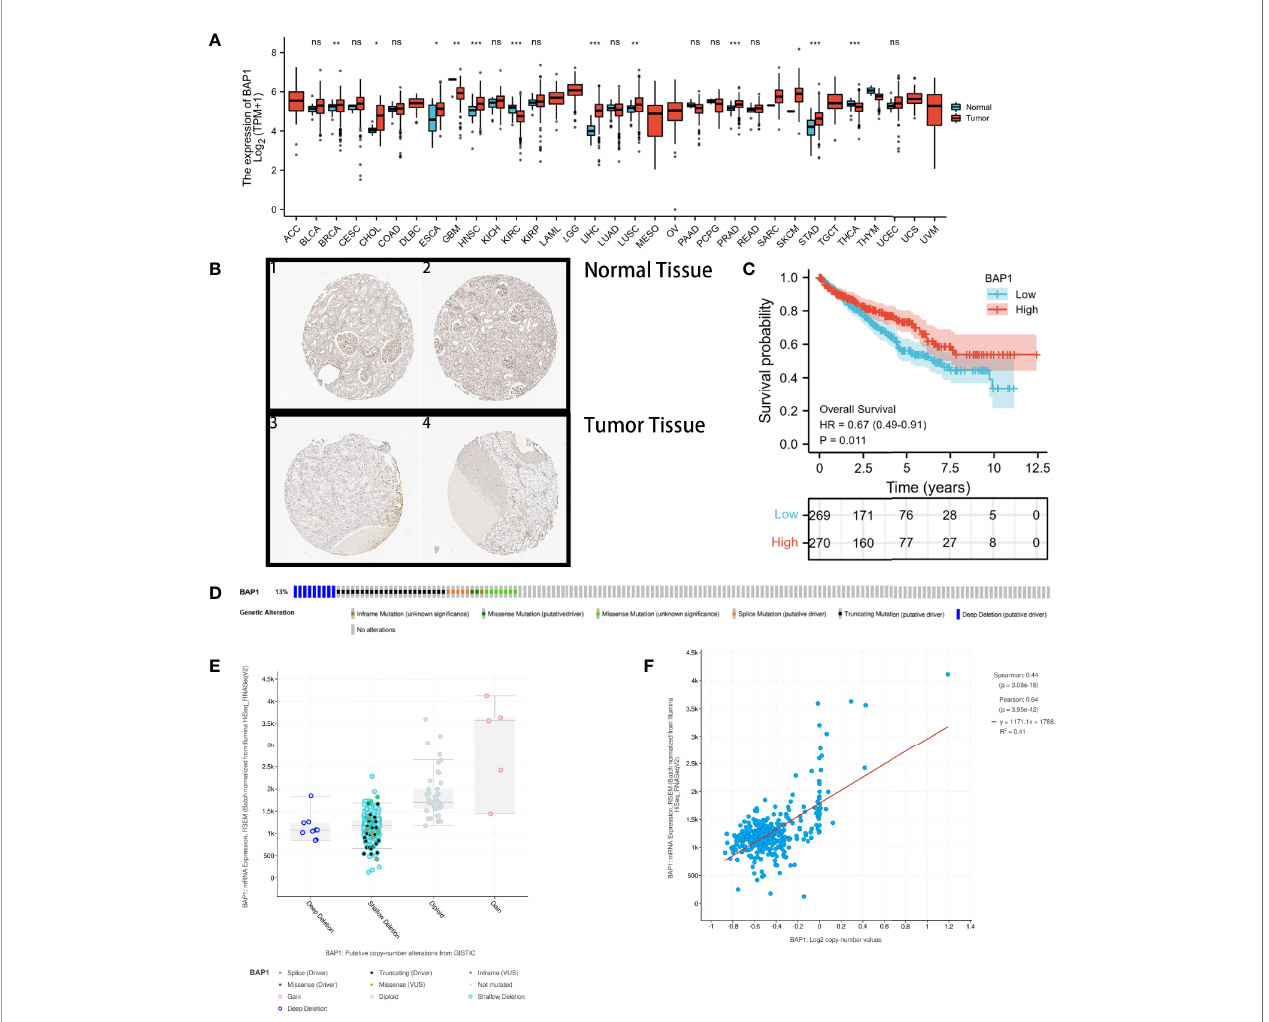
FIGURE 2 | BAP1 acts as a tumor suppressor in kidney renal clear cell carcinoma (KIRC). (A) Pan-cancer analysis of BAP1; (B) Immunohistochemical analysis of BAP1 in renal tumor and normal tissues; (C) Survival analysis comparing high- and low expression of BAP1; (D) Distribution of BAP1 genomic alterations inTCGA KIRC; (E, F) Relationship between copy number alterations and BAP1 expression: scatter plot (E) , correlation plot (F) . ns, not signi fi cant, p ≥ 0.05; *p < 0.05; **p < 0.01; ***p <